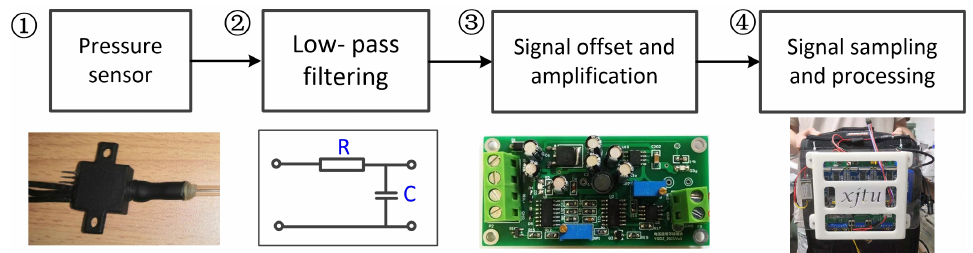
Figure 4. Signal processing and electronic system. (1) The air pressure sensor. (2) RC low-pass filtering circuit. (3) Modular for signal amplitude amplification and offset. (4) Embedded electronic system.